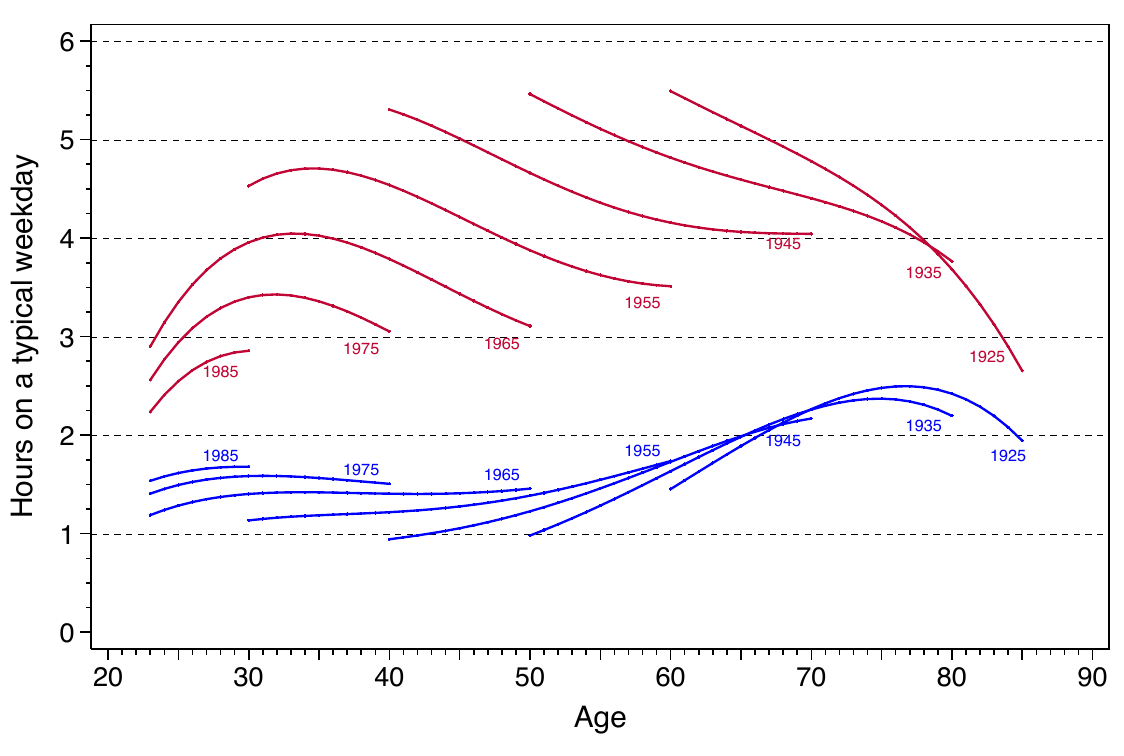
Figure 1: Life-course and cohort profiles of housework time. Notes: SOEP version 32.1 (1985–2015), release 2017. Red curves are women, blue curves are men. Curves are based on the models shown in Table